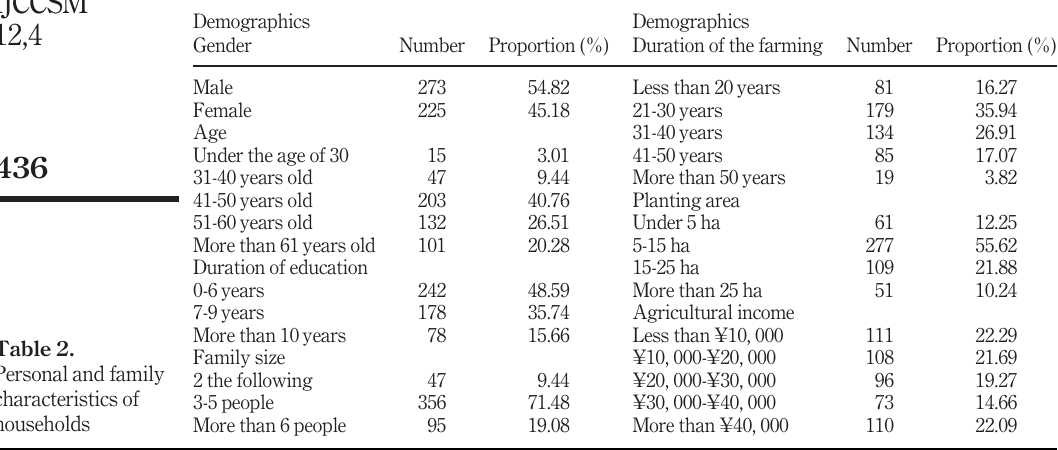
Table 2. Personal and